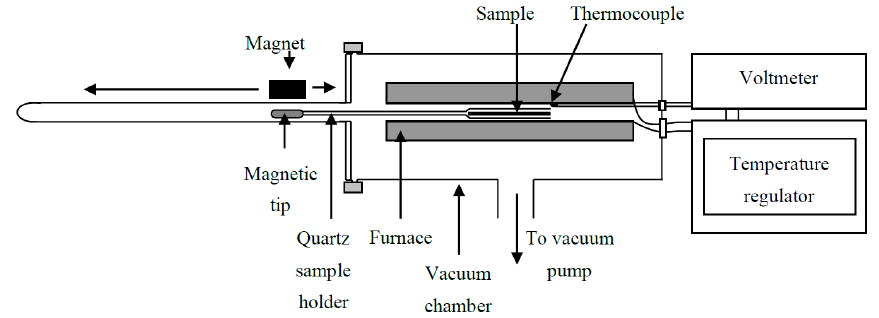
Figure 1. Schematic of the furnace annealing system.